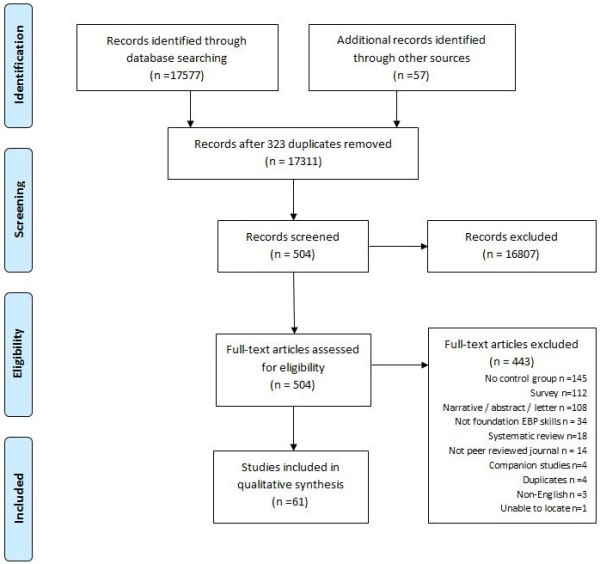
PRISMA flow diagram.